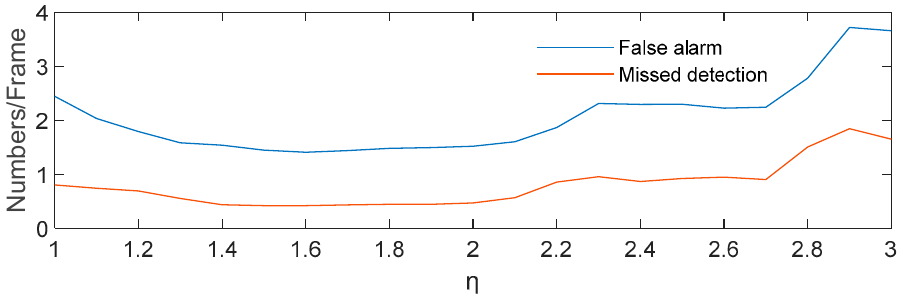
Figure 7. The change of average false alarm and missed detection number per frame with η .